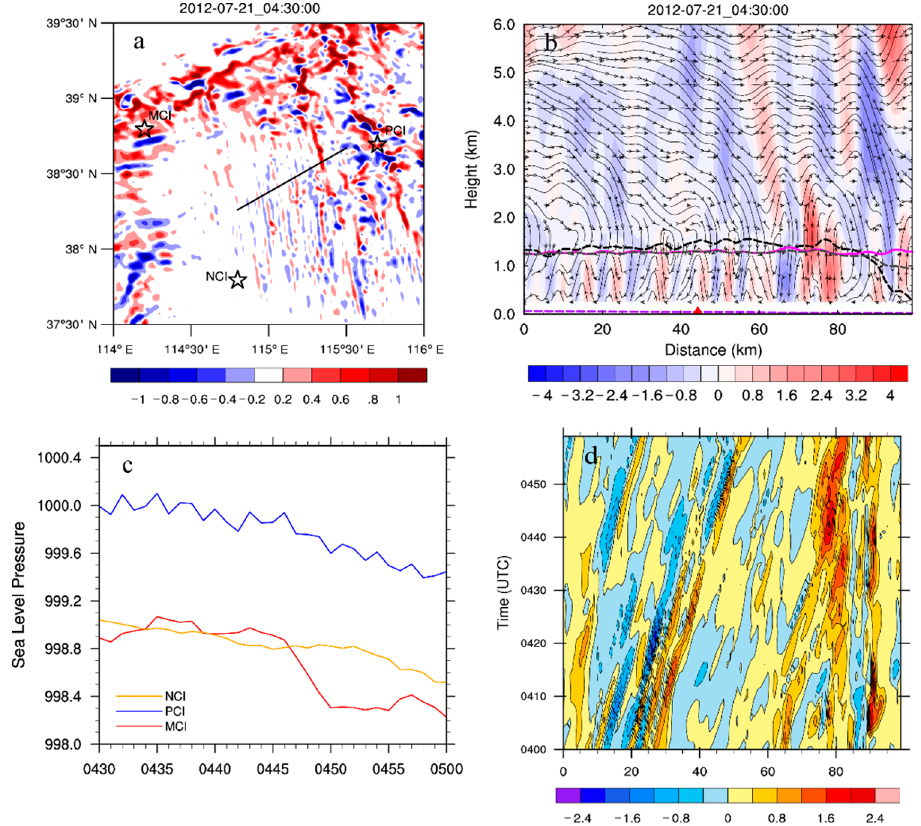
Figure 9. ( a ) Spatial distribution of vertical velocity (shading, units: m s − 1 ) at the height of 1 km at 0430 UTC. ( b ) Cross sections of the vertical velocity (shading, units: m s − 1 ), the wind field (streamlines), the LCL (gray dotted line), the PBLH (black dotted line), and the LFC (magenta solid line) along the black line in ( a ). ( c ) Time series of the sea level pressure at locations denoted by the stars in ( a ). The NCI, PCI, and MCI represent no convective initiation, plain convective initiation, and mountain convective initiation, respectively. ( d ) Time–distance plot of vertical velocity (shading, units: m s − 1 ) at the height of 1 km during the period from 0400 to 0500 UTC.